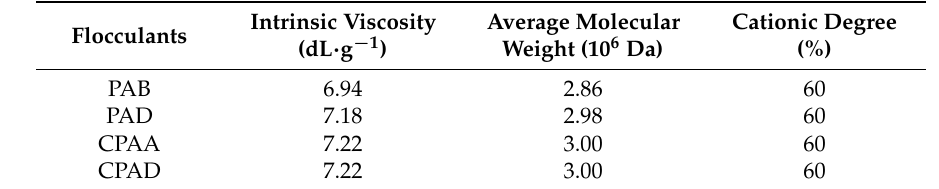
Table 2. Details of used flocculants in sludge conditioning